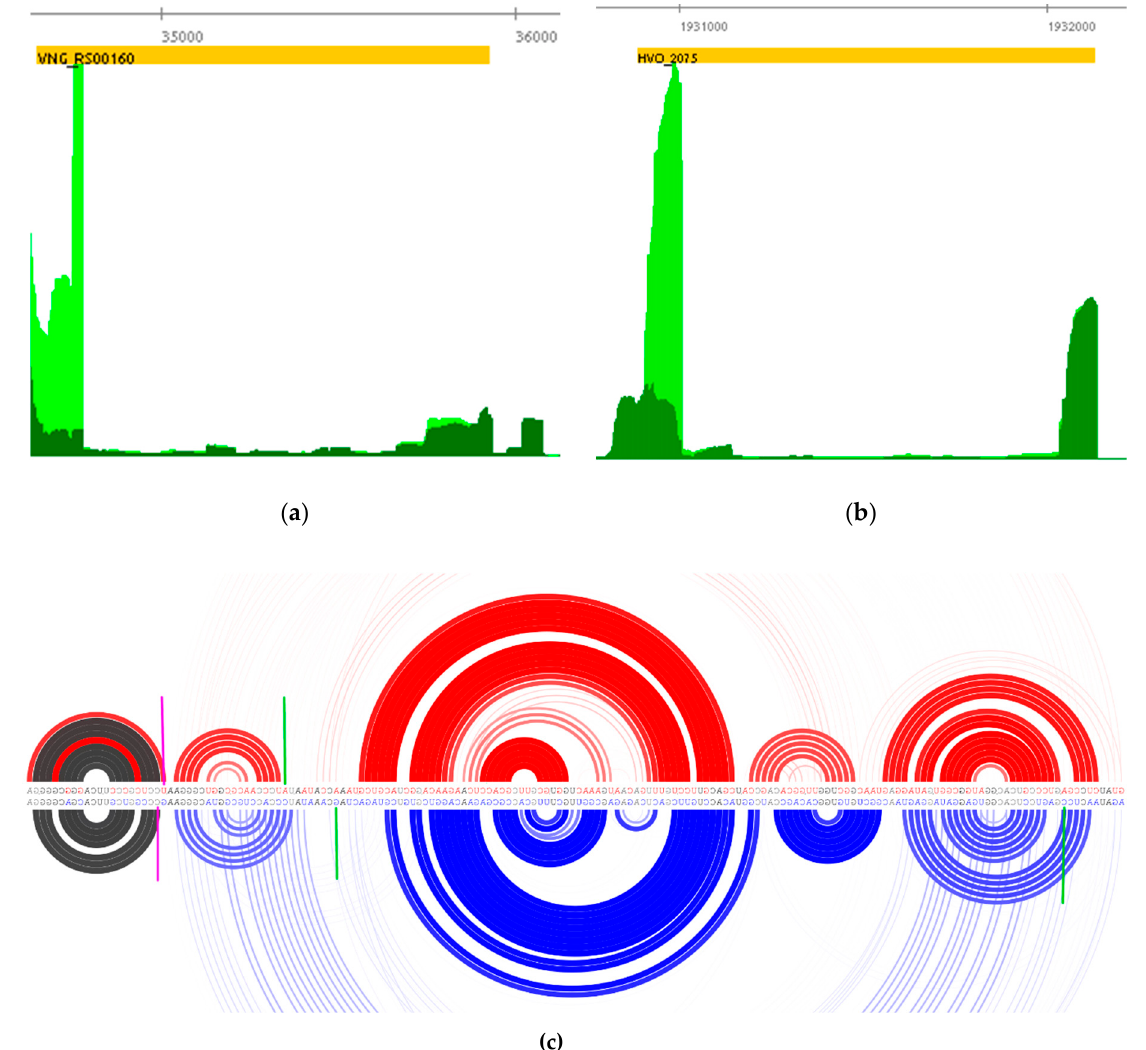
Figure 7. Gene tnpB transcript processing site signal (TEX − > TEX+) in ( a ) H. salinarum and ( b ) H. volcanii dRNA-seq datasets. Coding sequences are in reverse strand (orange rectangle), thus 5 ′ → 3 ′ direction is right to left. Aligned reads coverage along genomic coordinates for TEX+ and TEX − are shown in dark green and light green, respectively (normalized counts arbitrarily scaled). Statistical analysis showed the same results for the sot0042 family (RF02656) member within the VNG_RS00160 locus (TPS_8065_1) and HVO_2075 locus (TPS_077749). ( c ) Predicted rainbow diagram of sot0042 family representatives in H. salinarum (top, red) and H. volcanii (bottom, blue), 5 ′ → 3 ′ direction is right to left. Arc thickness is proportional to the thermal average probabilities of base pairs. Magenta markers point to hairpin induced false positive TSS. Green markers indicate transcript processing sites (TPS) inferred by statistically significant signal suppression after TEX treatment (right to left): TPS_077749, TPS_077728, TPS_8058_1.